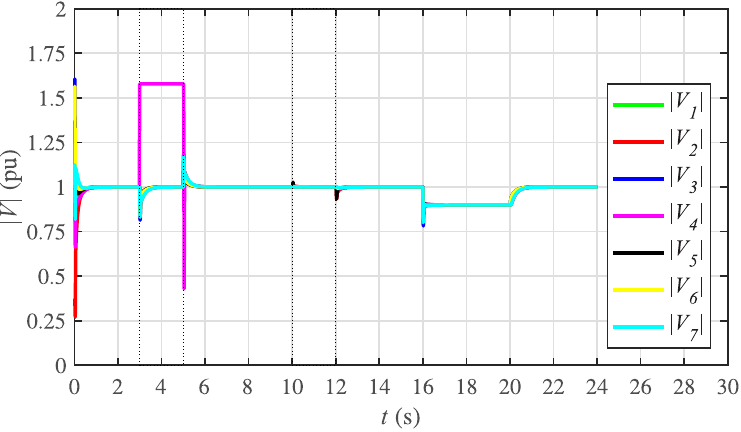
Fig 39. Voltage regulation with leader-follower and leaderless consensus under case